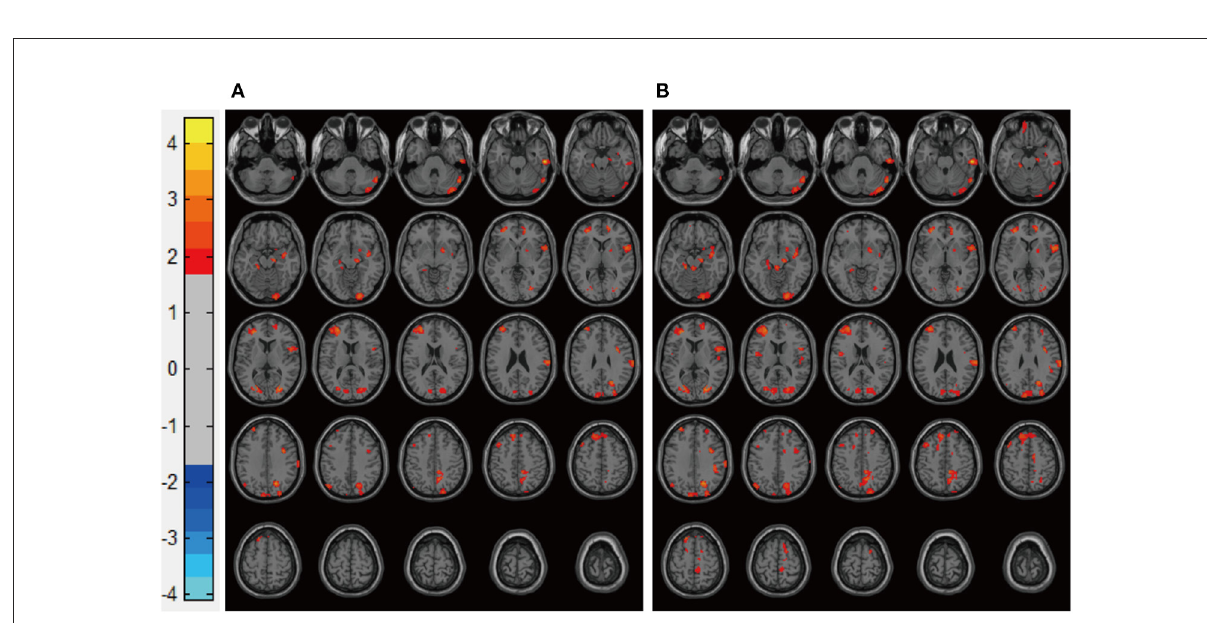
FIGURE3 Representative images of pretreatment rs-CBF in patients with BP experiencing their first manic episodes compared with the rs-CBF of healthy controls. (A) Before lithium monotherapy, (B) before VPA monotherapy. rs-CBF, resting-state cerebral blood flow; BP, bipolar disorder; VPA,